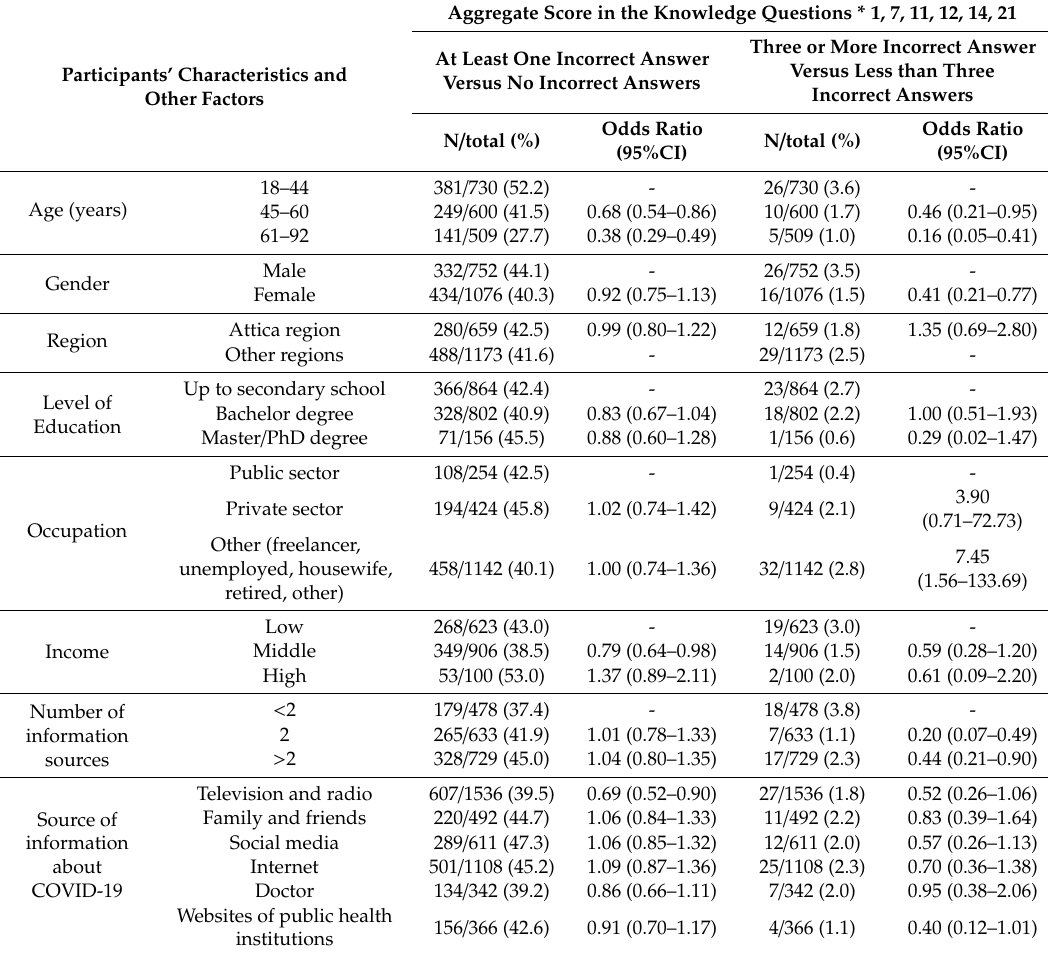
Table 3. Multivariable analysis of participants’ characteristics and misperceptions about COVID-19.